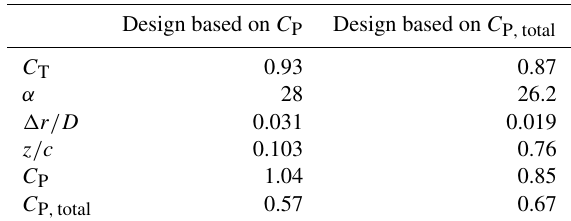
Table 1. Comparison of designs based on C P and C P , total Design based on C